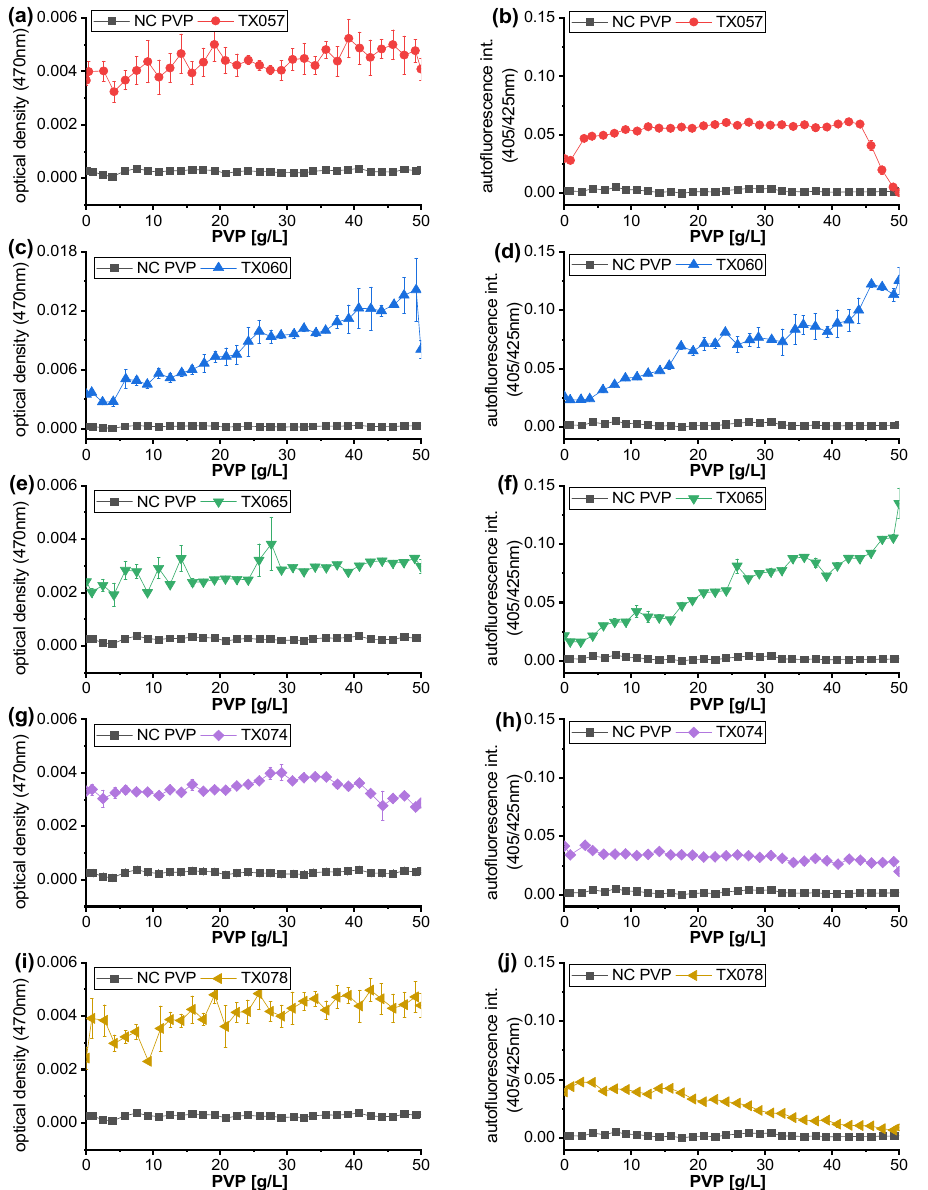
Figure 6. Dose-response curves of isolated Achromobacter spanius strains TX057, TX060, TX065, TX074 and TX078 against 40 kDa PVP. ( a , c , e , g , i ) show the optical density of the segments measured by microphotometry and ( b , d , f , h , j ) show the normalized autofluorescence intensity of the segments measured by microfluorimetry. Each dot represents the mean and the error bars represent standard deviation of 10 ± 3 droplets.